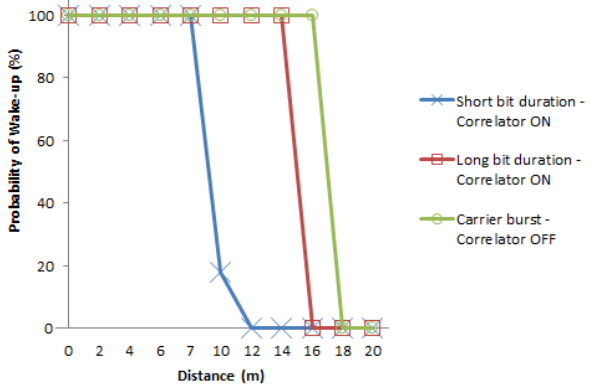
Figure 18. Probability of wake-up vs. distance for the correlator ON and OFF settings, for short and long bit duration and under no interference scenario.